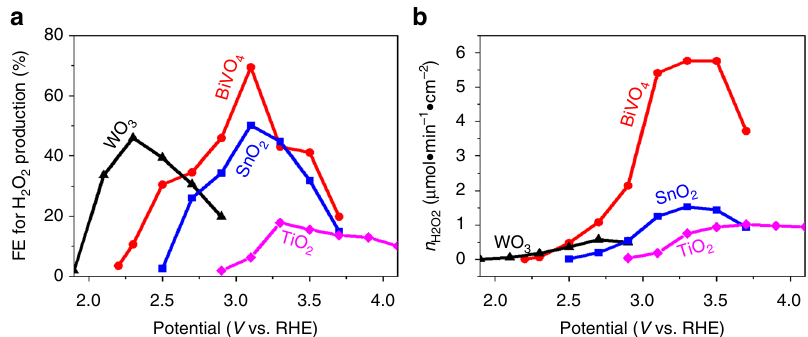
Fig. 3 The faraday ef fi ciency (FE) and mole amount of H 2 O 2 under dark. a The FE and b the mole amount ( n ) of H 2 O 2 generation ( n ) vs potential ( V ) without illumination. Both show that BiVO 4 has the highest FE and n for H 2 O 2 production over other metal oxides